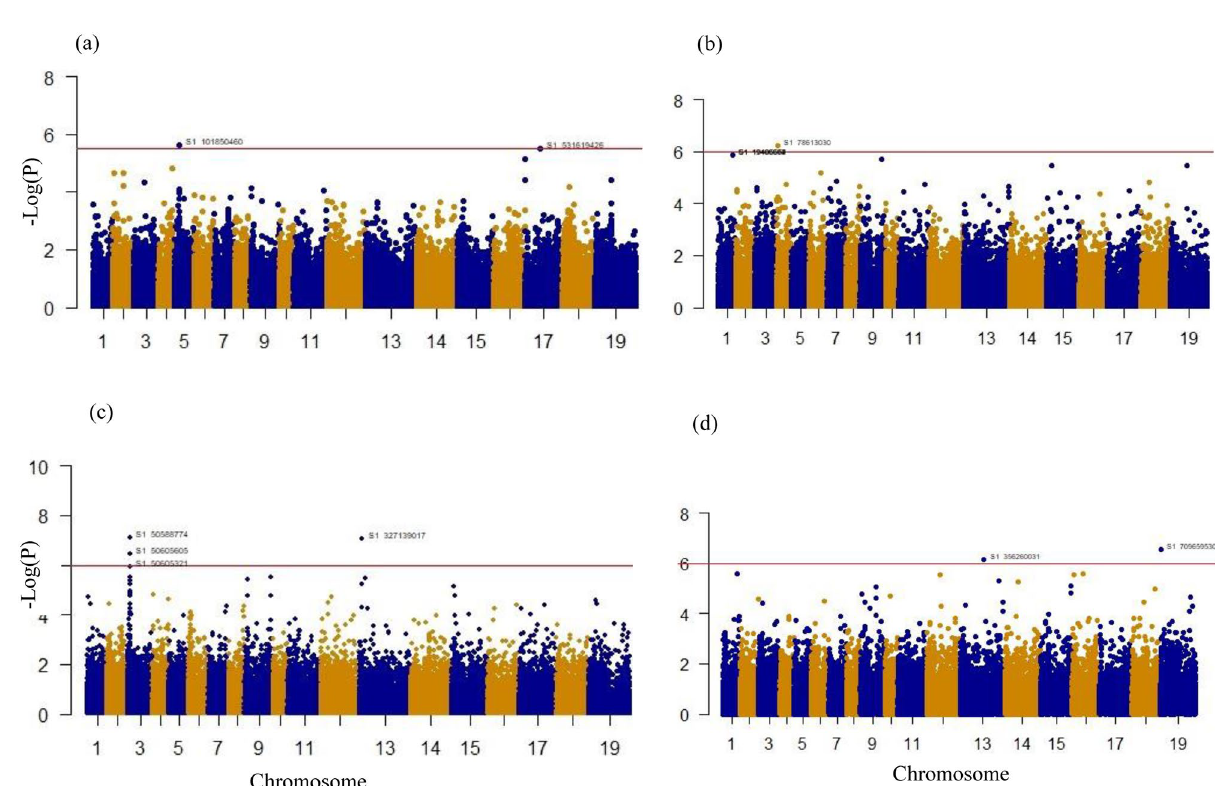
Figure 3. Manhattan plots of association analysis using mixed linear model (MLM) model P + K for pathotypes ( a ) 5X, ( b ) 2B, ( c ) 3A and ( d ) 3D. The horizontal line represents the threshold of significance (− log 10 0.5/104,824 SNPs =